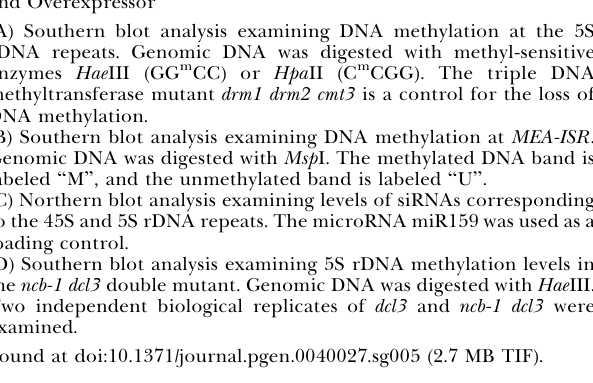
Table S1. Nuclei Counts for SmD3 or SmB Localization Relative to AGO4 Table S2. Nuclei Counts for HYL1 Localization Table S3. Nuclei Counts for the coilin Mutant Found at doi:10.1371/journal.pgen.0040027.st003 (93 KB PDF). Table S4. Nuclei Counts for RdDM Mutants Table S5. Nuclei Counts for NRPD1b Localization in ago4 and nrpd2 Mutants Table S6. Nuclei Counts for NRPD2 Localization Table S7. Nuclear Foci Counts for 45S, 5S, and CEN FISH Experi- ments Table S8. Nuclear Foci Counts for NOR2 and NOR4 Table S9. Nuclei Counts for DRM2-Myc Localization Found at doi:10.1371/journal.pgen.0040027.st009 (80 KB